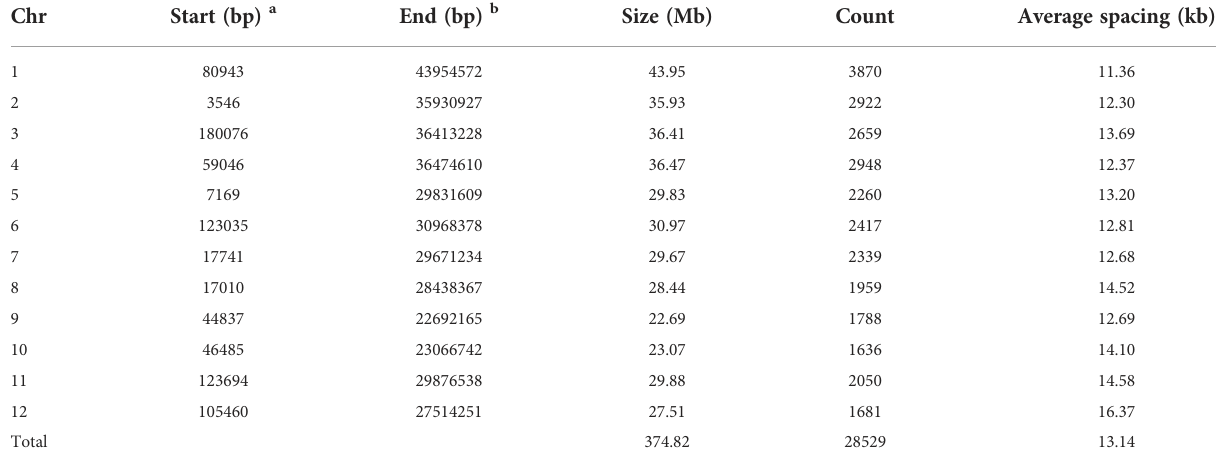
TABLE 2 Distributions of markers used in GWAS on